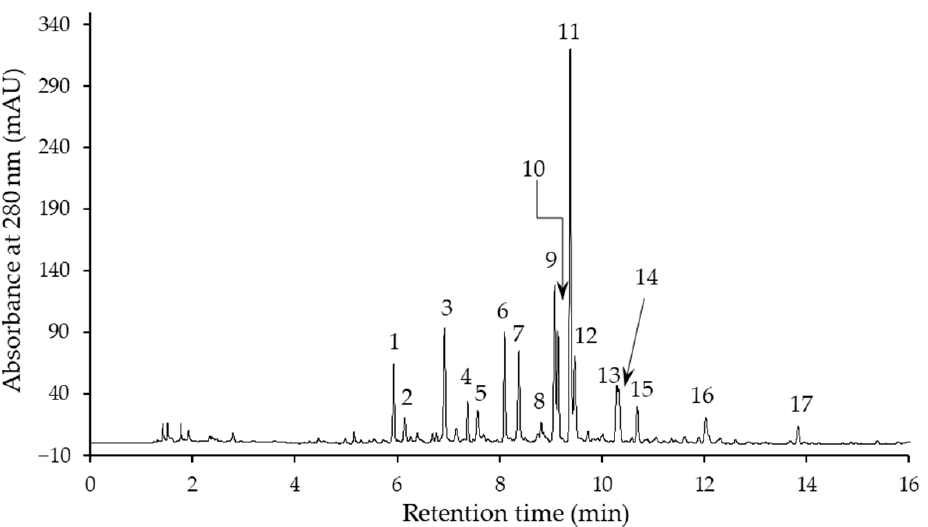
Figure 1. Chromatogram of a flax extract obtained by means of high-performance liquid chromatog- raphy with a diode-array detector (HPLC–DAD). Table 2. Absorption maxima ( λ max ) of the UV spectra from the HPLC–DAD analysis, and the parent